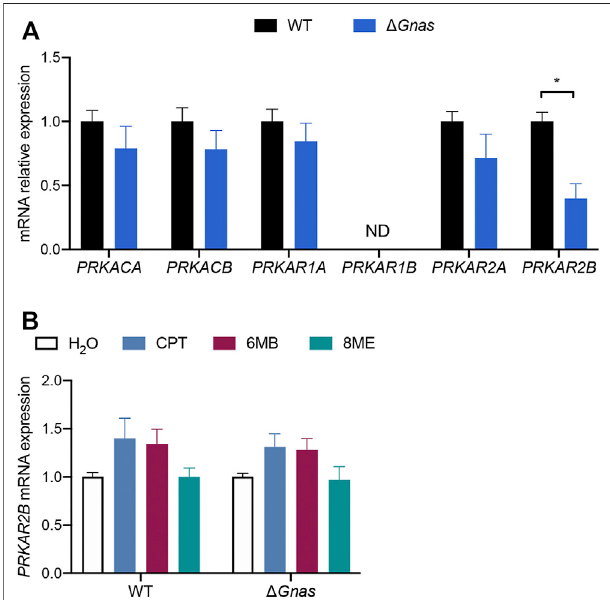
FIGURE 2 | Δ Gnas DCs have decreased expression of PRKAR2B, whoseexpressionisinsensitivetoincreasesincAMPlevels. (A) Proteinkinase A (PKA) subunit expression in WT and Δ Gnas DCs; n = 5, p < 0.05. (B) PRKAR2B expression in WT and Δ Gnas DCs after treatment with the cAMP analogs CPT (non-selective), 6MB (PKA-selective), and 8ME (Epac- selective), (each 50 μ M, 24 h); n = 3, data are not statistically signi fi